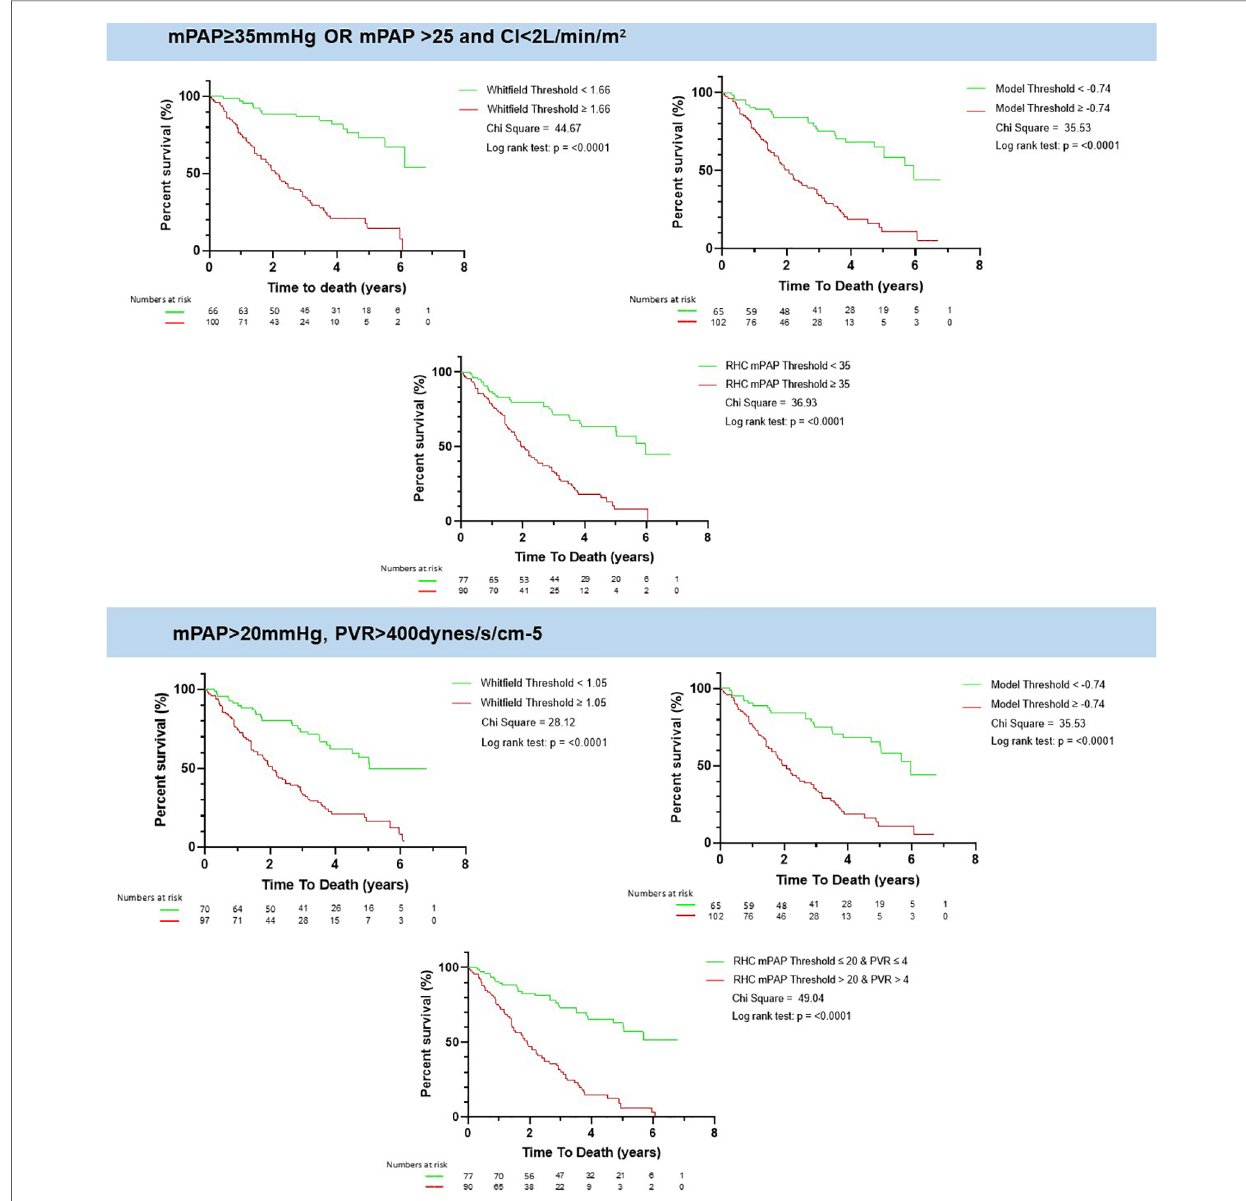
FIGURE 4 Kaplan meier of whit fi eld and lung disease CLD-PH MRI model and the RHC measured mPAP. There is an increased mortality above the selected thresholds of Whit fi eld model, CLD-PH MRI model and RHC-measured mPAP for both de fi nitions of severe PH according to the ESC/ERS guidelines. mPAP: mean pulmonary artery pressure; PVR: pulmonary vascular resistance; CI: cardiac index; CLD: chronic lung disease; PH: pulmonary hypertension; RHC: right heart catheter; MRI: magnetic resonance